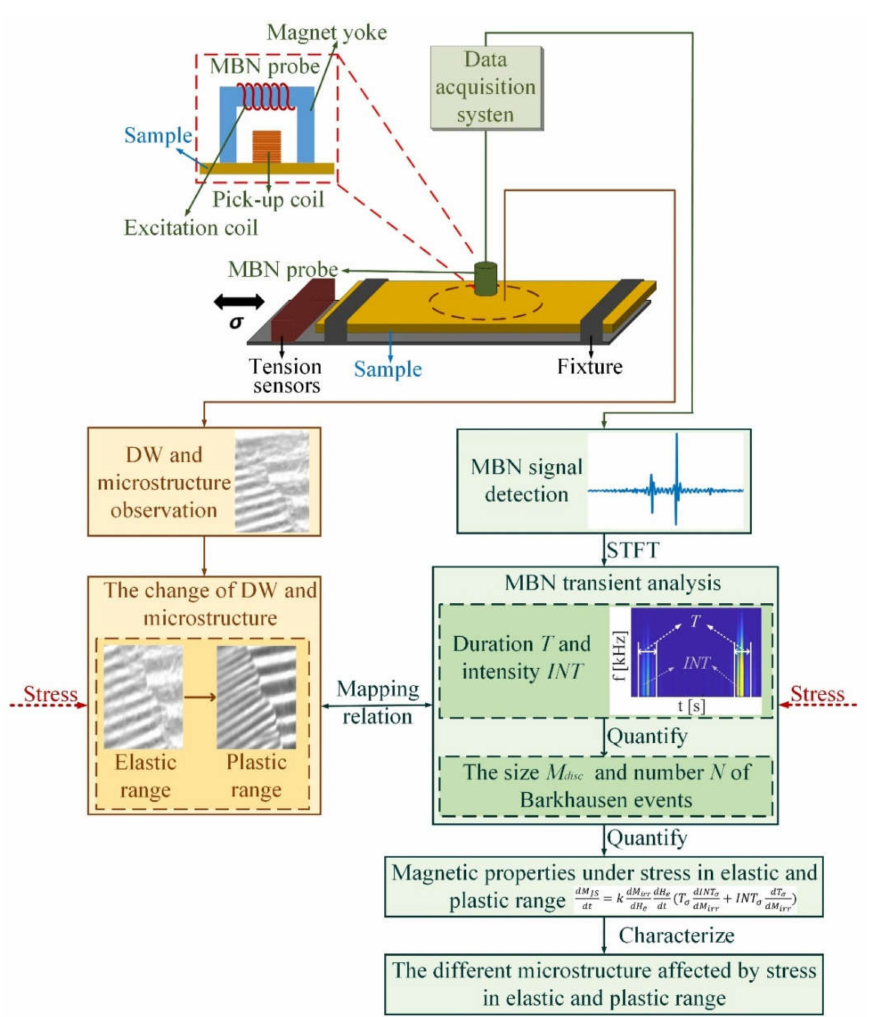
Figure 2. The approach of MBN transient analysis to evaluate the variation of the magnetic properties under stress in elastic and plastic